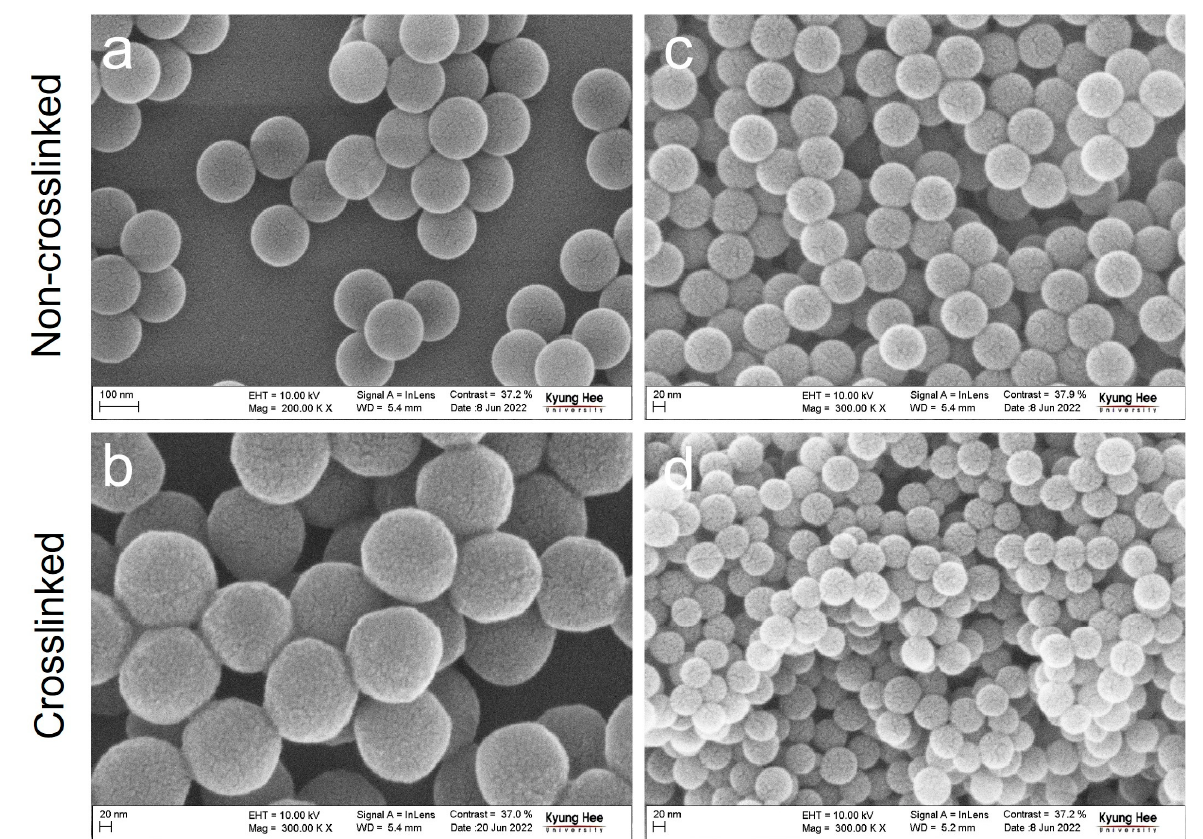
Figure 2. SEM images of PS NPs. Di ff erent surfactants were added: SDS ( a , b ) and CTAB ( c , d ). The top and bo tt om rows indicate non-crosslinked PS NPs and partially crosslinked PS NPs at 𝑡 (cid:3005)(cid:3023)(cid:3005) = 70 min, respectively.